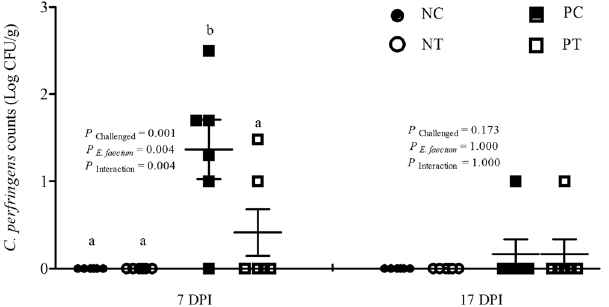
Figure 2. Effect of dietary E . faecium 11181 on bacterial translocation to the liver of broiler chickens challenged with NE. Each dot (n = 6) represents an individual sample under different treatments. The lowercase letters on the dots indicate significant differences ( P < 0.05). NC = Non-NE-infected + no E. faecium treatment, NT = non-NE-infected + E. faecium treatment, PC = NE-infected + no E. faecium treatment, PT = NE- infected + E. faecium